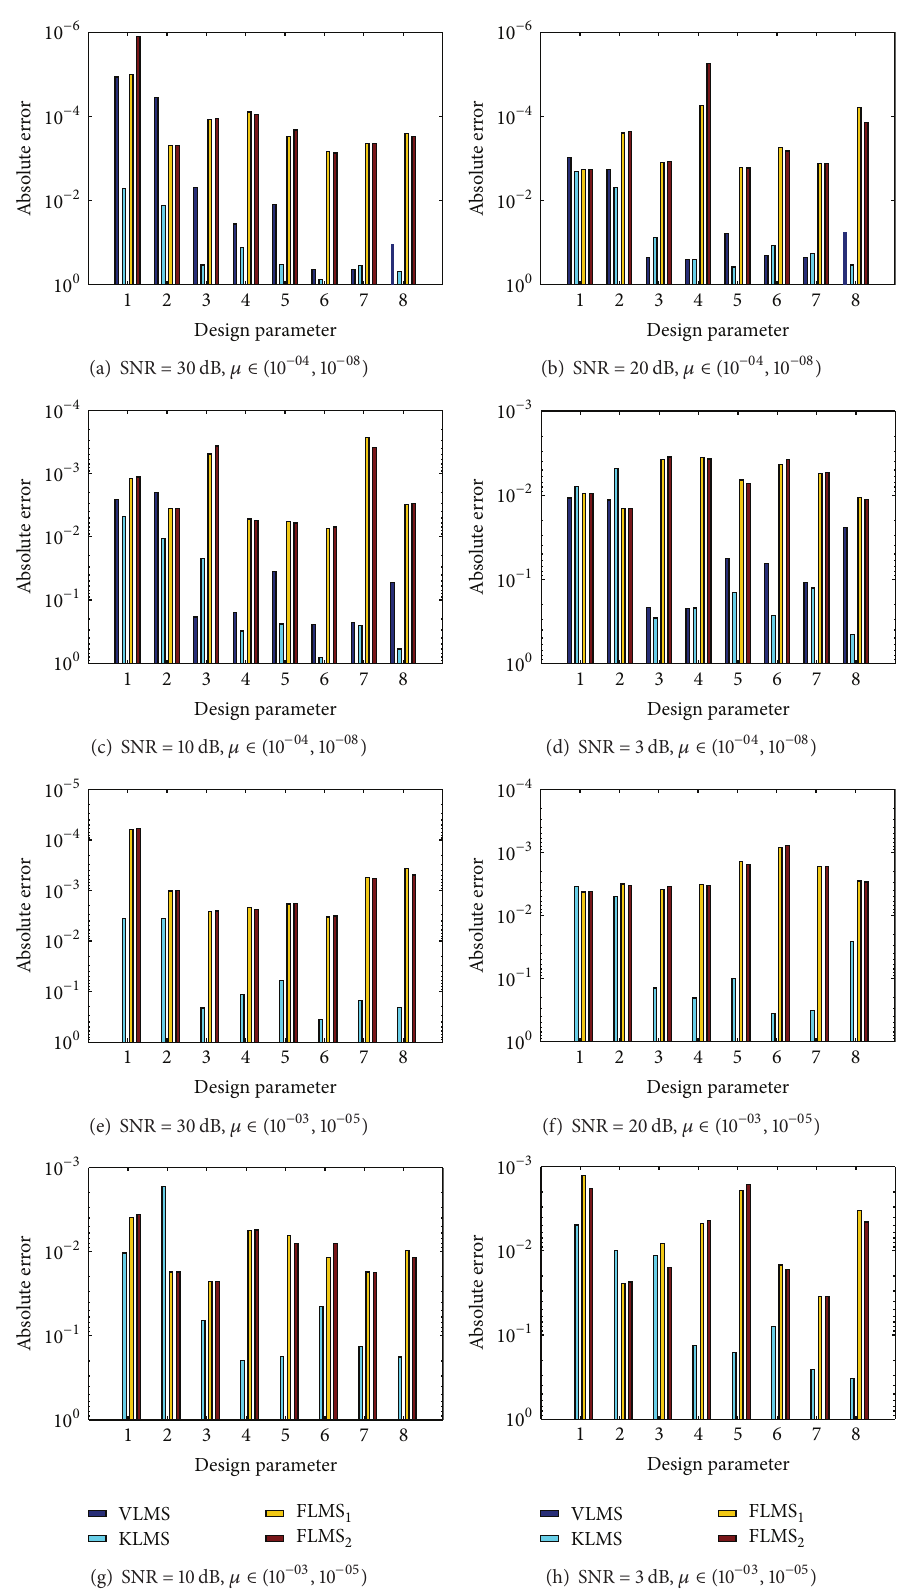
Figure 3: Comparison on the basis of absolute error from true values for INCAR model in case study